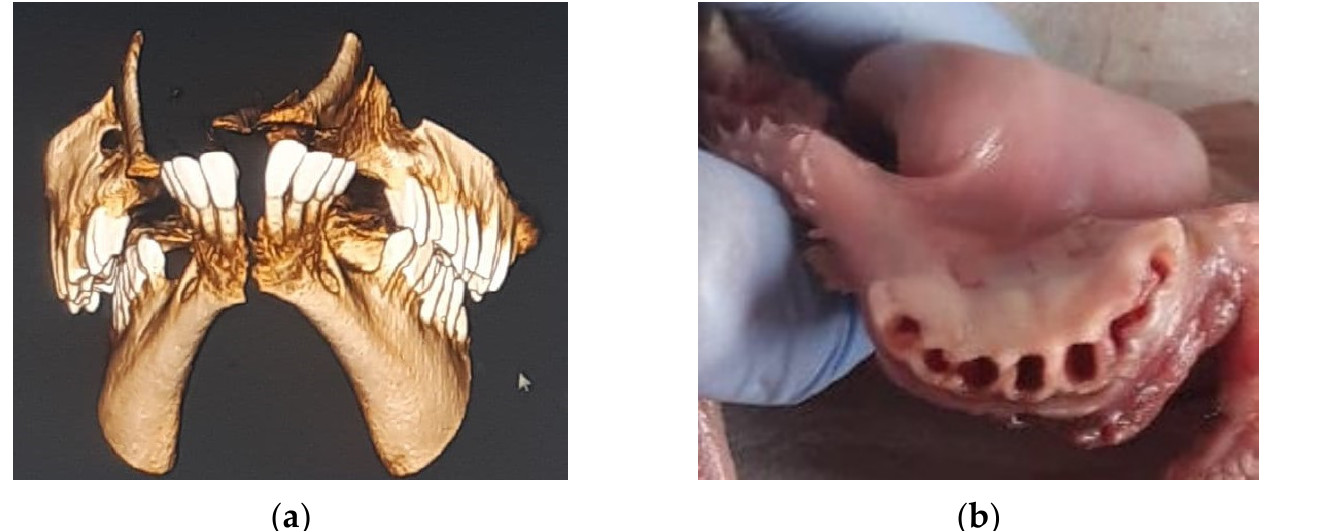
Figure 1. The tridimensional reconstruction of lamb before: ( a ) teeth extraction in DICOM format and ( b ) clinical view of lamb skull after teeth extraction.